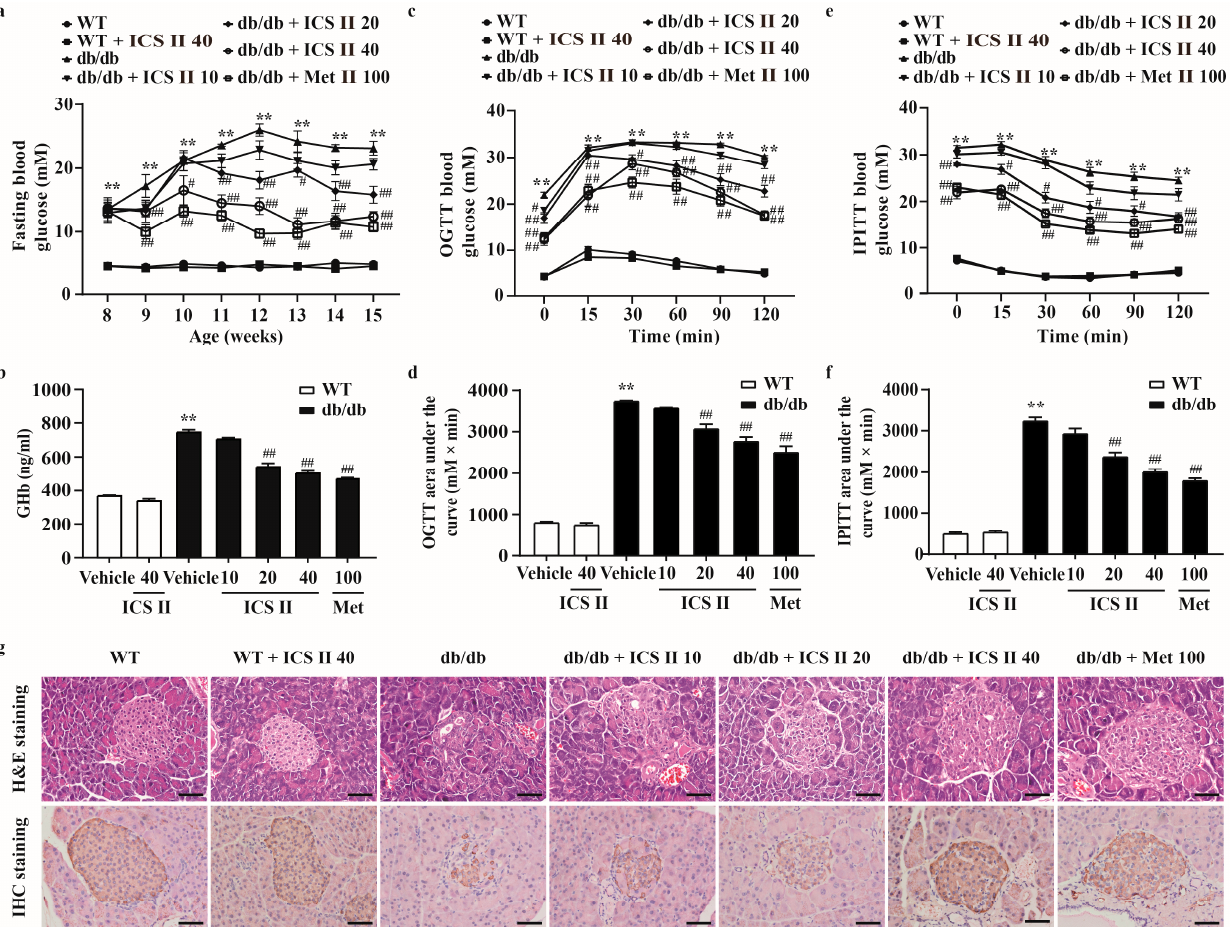
Figure 1. ICS II improved glucose metabolism, insulin sensitivity and pancreatic islet architecture in db/db mice. ICS II at doses of 10, 20, or 40 mg · kg − 1 was administered to db/db mice or WT mice (starting from 8 weeks old) for 7 weeks. ( a ) 12 h fasting blood glucose of the mice ( n = 8). ( b ) GHb level ( n = 8). OGTT ( c , d ) and IPITT ( e , f ) were performed after 6 weeks of ICS II administration and the AUCs were calculated ( n = 8). ( g ) H&E staining and insulin immunostaining ( × 400, scale bar = 50 µ m). Data were expressed as mean ± SEM. ** p < 0.01 versus WT group; # p < 0.05 and ## p < 0.01 versus db/db group.